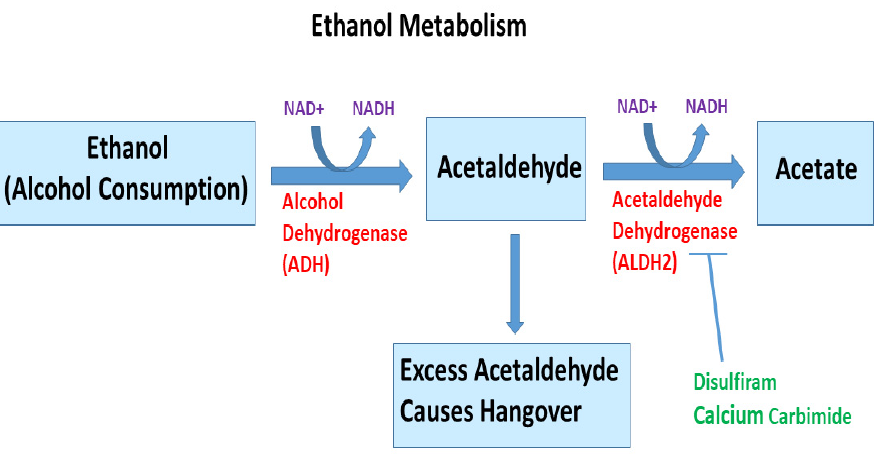
Figure 3. Ethanol metabolism. Ethanol, an alcohol found in nature and alcoholic drinks, is metabo- lized through a complex catabolic metabolic pathway. In humans, in the presence of enzyme alcohol dehydrogenase and NAD + , ethanol is metabolized to acetaldehyde, which is further converted to acetate and acetyl-CoA in the presence of acetaldehyde dehydrogenase and NAD + . Once acetyl-CoA is formed, it becomes a substrate for the citric acid cycle, ultimately producing cellular energy and releasing water and carbon dioxide (not shown). The liver is the major organ that metabolizes ethanol. Disulfiram and calcium carbamide can inhibit ALDH2 activity. Excess acetaldehyde can cause hangover.